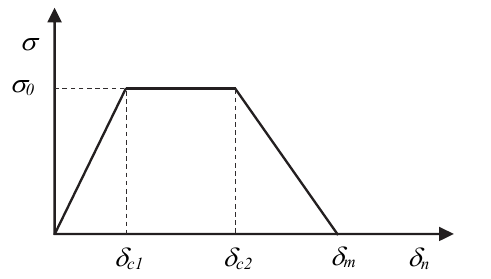
Figure 2: Trilinear traction-separation relationship for mode I loading condition.